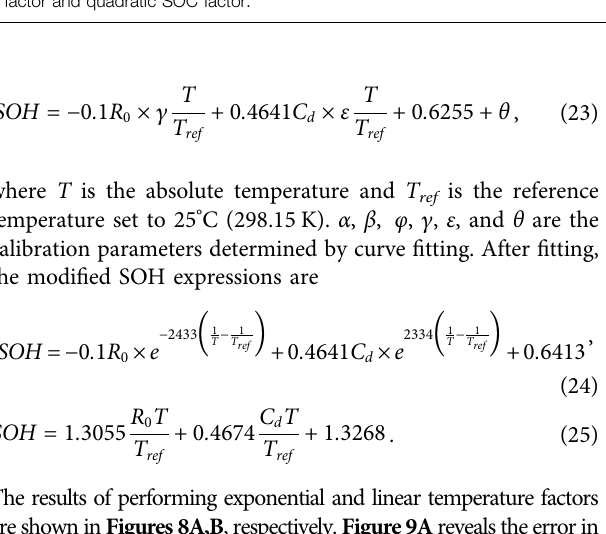
FIGURE9|(A) ErrorsofSOH expressions withexponential temperature factor andlineartemperature factor. (B) ErrorsofSOHexpressionswithexponentialSOC factor and quadratic SOC factor.